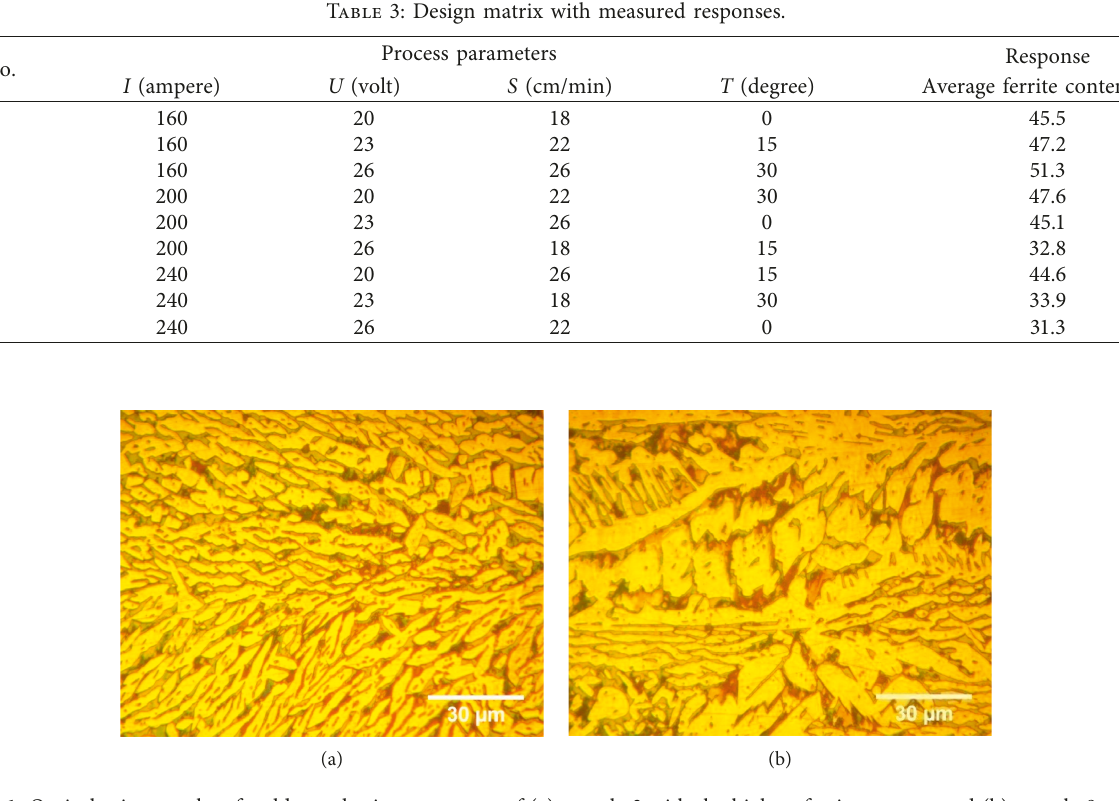
Figure 1: Optical micrographs of weld metal microstructures of (a) sample 3 with the highest ferrite content and (b) sample 9 with the lowest ferrite content. Table 4: ANOVA and R -square table for ferrite content reduced quadratic